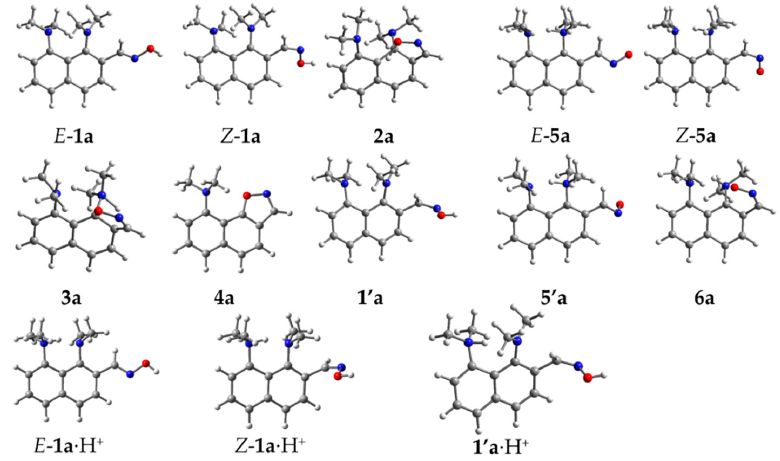
Figure 1. Optimized geometries of studied reaction intermediates for 1a → 4a transformation.